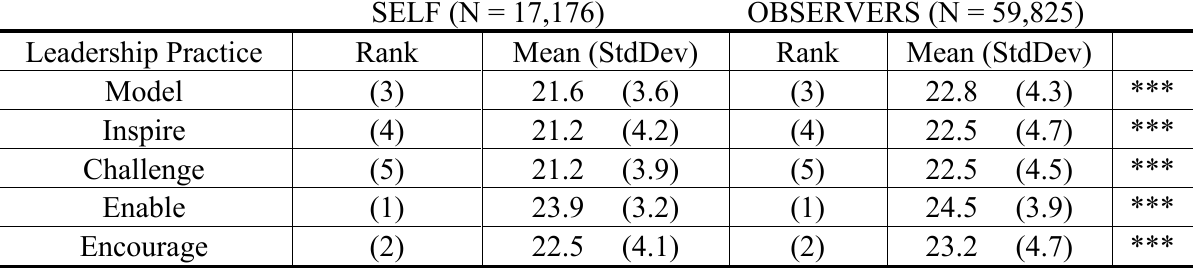
Table 2. Comparisons Between Self and Observers on the Student LPI.